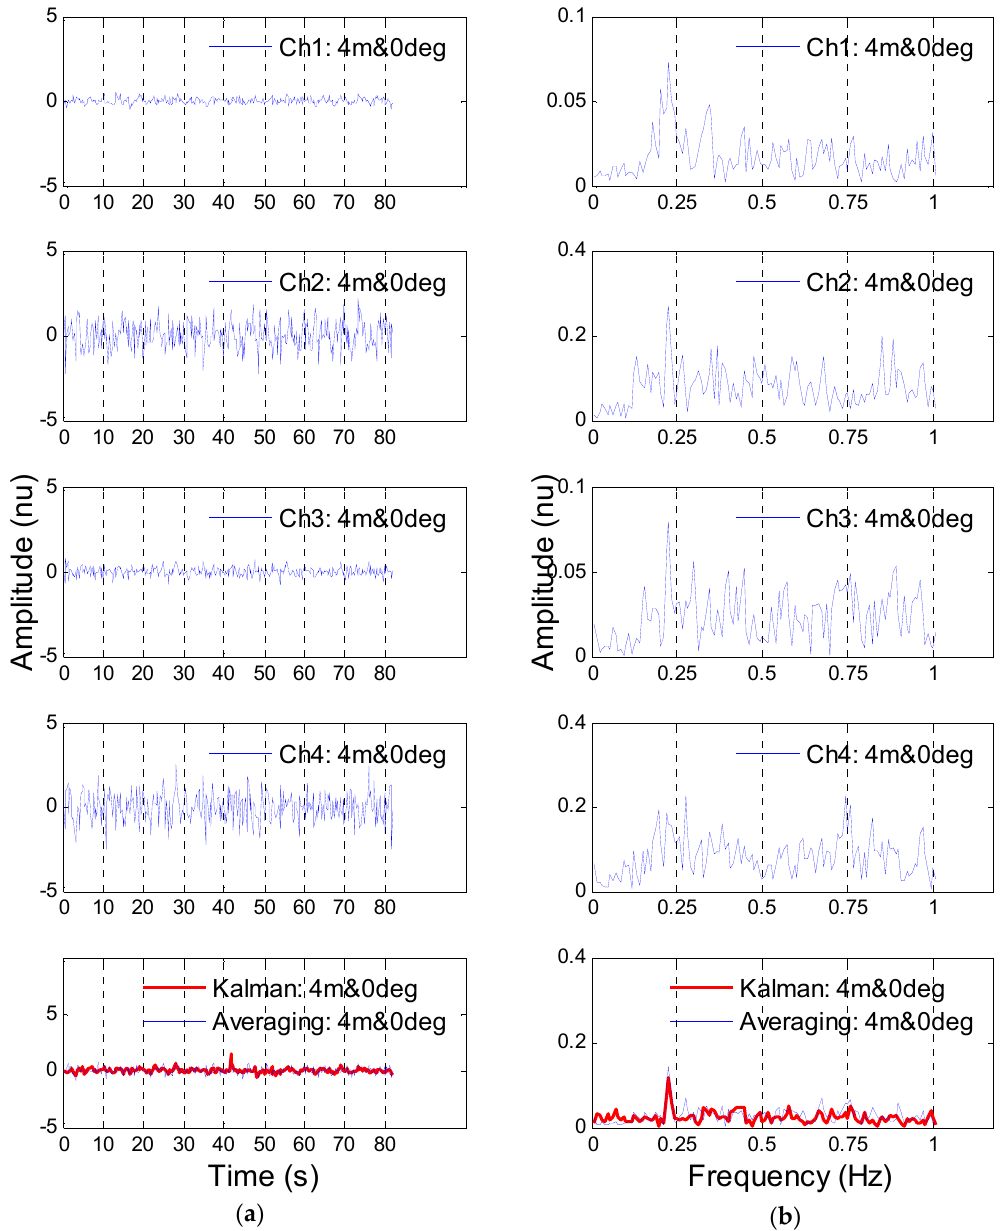
Figure 8. Four waveforms detected by the target association and the data fusion result ( a ) and their corresponding power spectrum in the frequency domain ( b ) when the volunteer was measured at the position (4 m, 0°). The rows from top to bottom are the waveforms from channel 1, 2, 3, 4 and the detected respiration, respectively. The detected respiration was fused by two methods: one is the Kalman filtering proposed in this paper and the other is a simple method based on averaging all four waveforms.